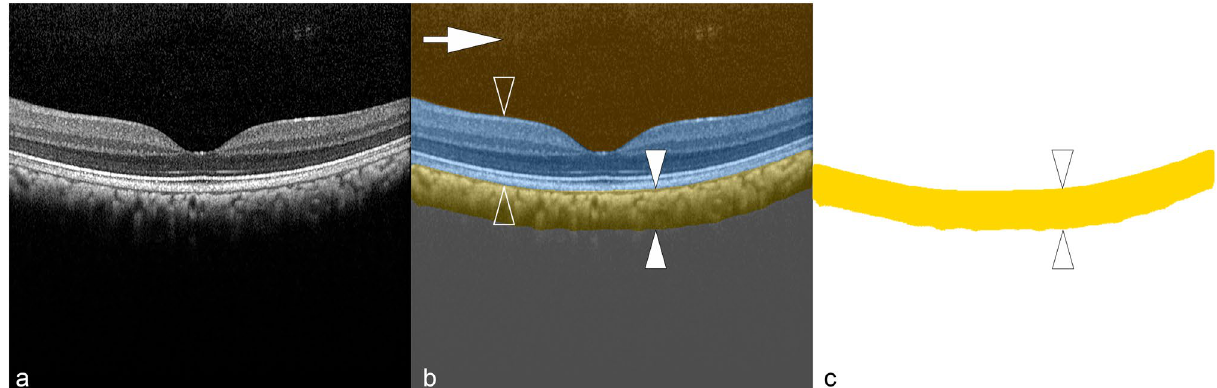
Figure 1. Illustration of automatic deep learning choroidal segmentation. ( a ) An original B-scan was exported from the device followed by ( b ) an automatic deep learning-based segmentation of the posterior eye into its main compartments. The deep learning predictions are displayed as overlays. The vitreous is highlighted in brown (arrow), the retina in blue (two open arrowheads), and the choroid in yellow (two white arrowheads), respectively. ( c ) Specific measurements were then made on the segmented choroid (yellow, two white